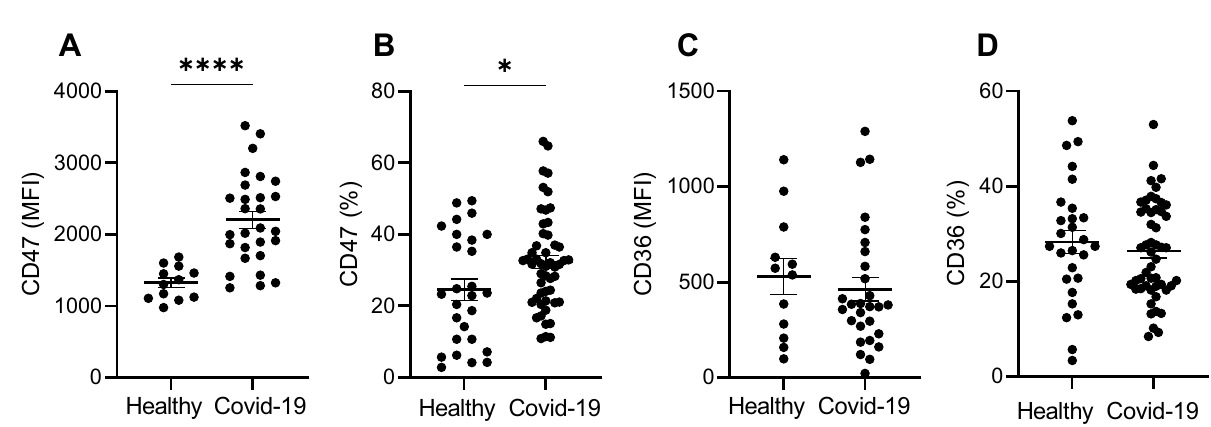
Figure 3. Expression of ”eat me” and ”don’t eat me” markers on neutrophils. Neutrophils from patients with COVID-19 infection show increased expression of ”don’t eat me” marker CD47 ( A , B ). Whereas, ”eat me” marker CD36 is expressed on comparable levels in both COVID-19 patients and healthy controls ( C , D